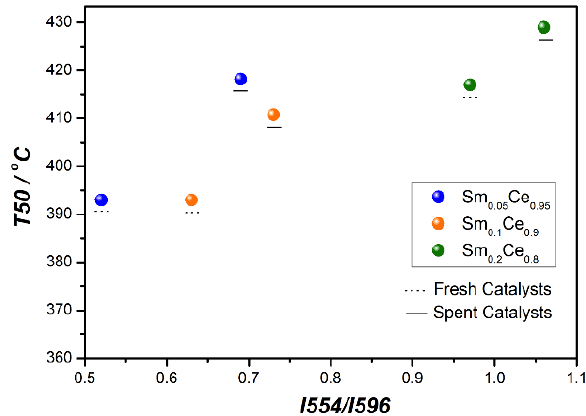
Figure 7. The relation between T50 and I 554 /I 596.